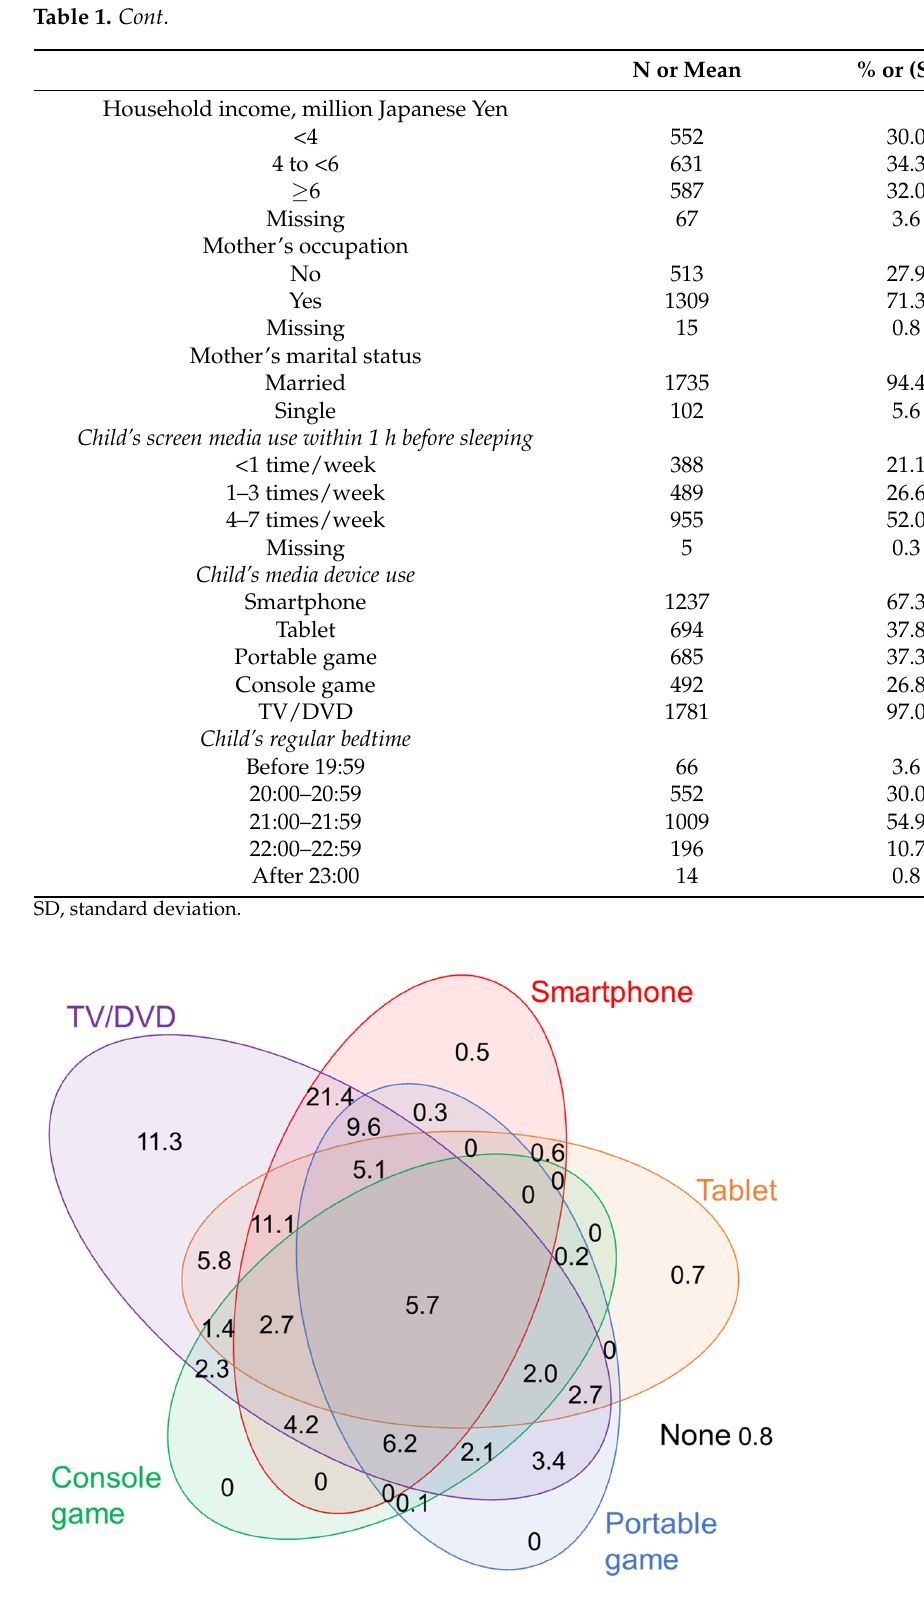
Figure 1. Venn diagram of children’s media use. Values are in %.